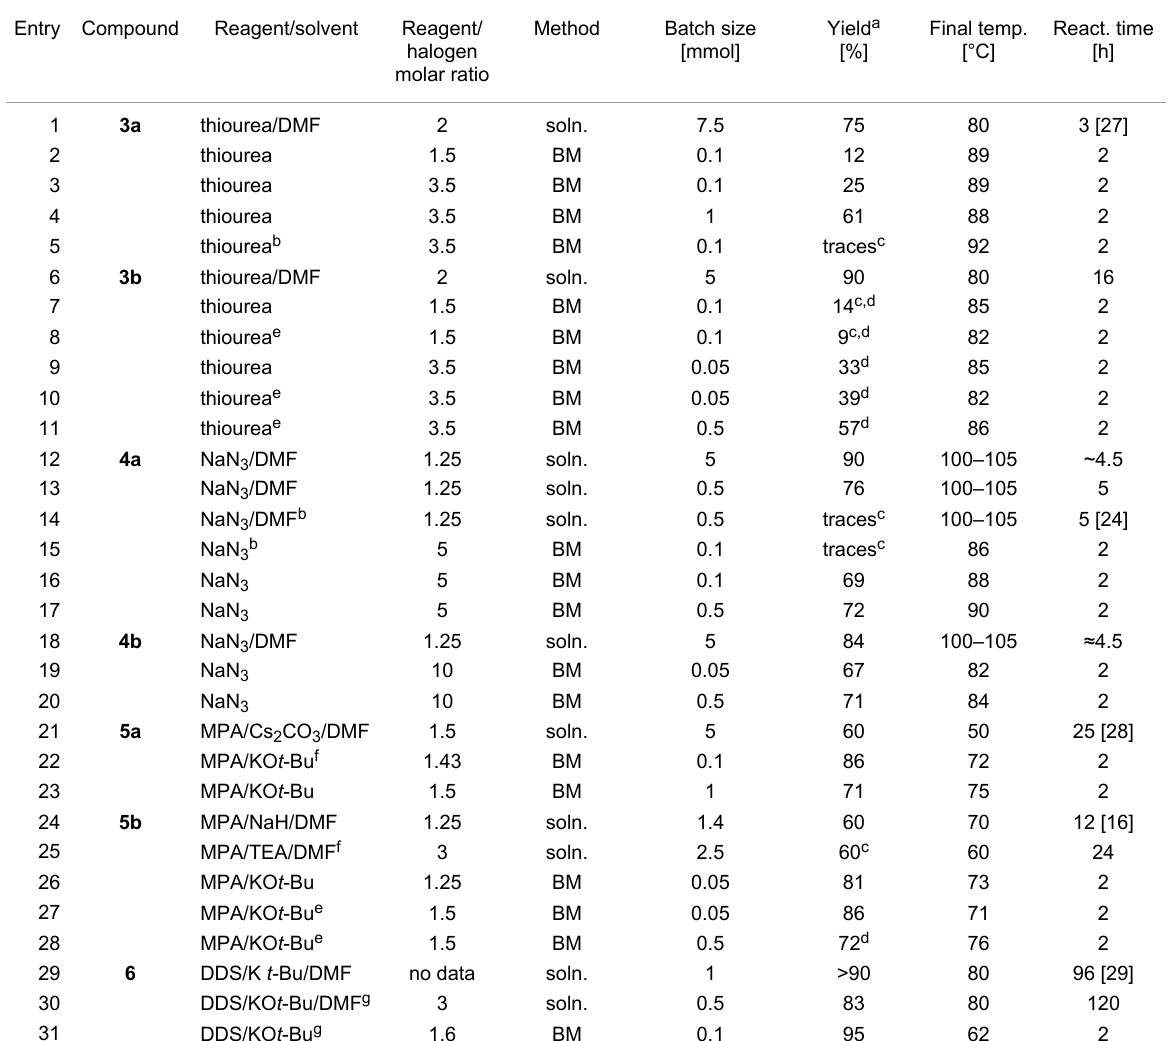
Table 1: Comparison of classic and green methods for the preparation of CD